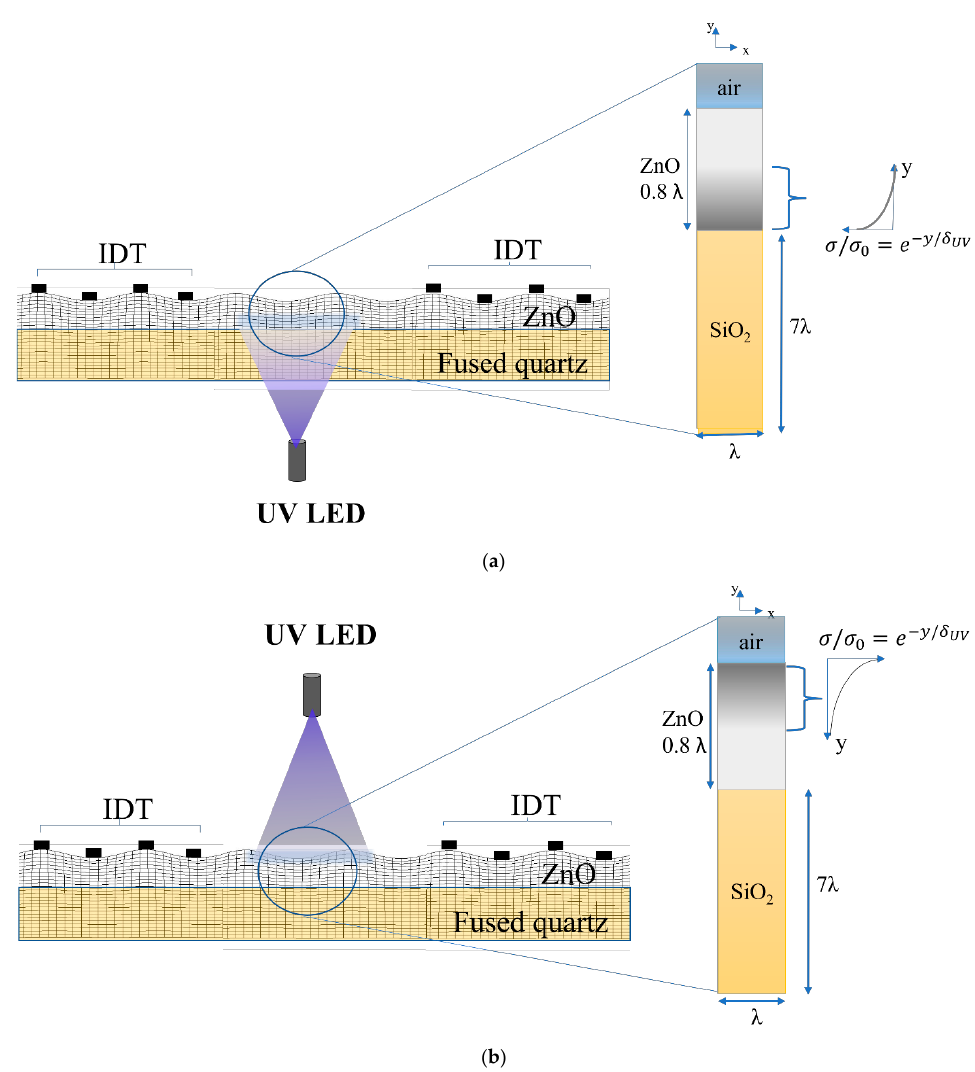
Figure 6. The schematic diagram of the ZnO/SiO 2 -based device under UV illumination ( a ) from top and ( b ) from bottom. The shaded gray scales in the details represent the conductivity profiles (in- duced by the UV adsorption) inside the ZnO layer. The picture is not in